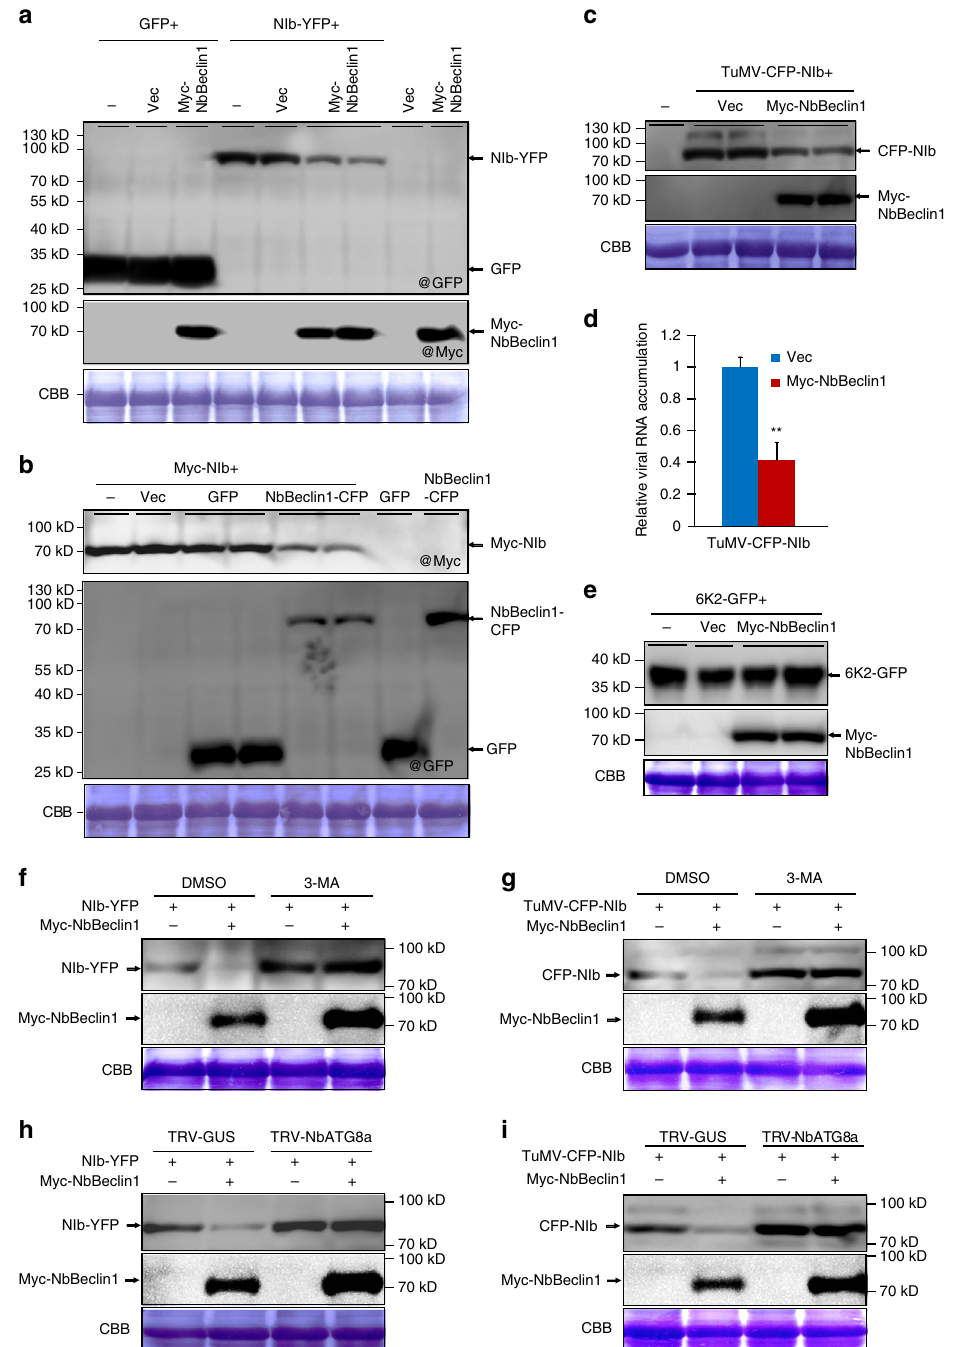
Fig. 5c,d,f,g). A TRV-based virus-induced gene silencing (VIGS) vector was employed to silence NbATG8a and NbATG8f , and knockdown of NbATG8a rather than NbATG8f remarkably inhibited NbBeclin1-mediated degradation of NIb-YFP or CFP- NIb (Fig. 5h, i and Supplementary Fig. 7a – c). A GFP protein that is relatively resistant to the autophagy pathway was used as a control (Fig. 5a, b and Supplementary Fig. 5h –